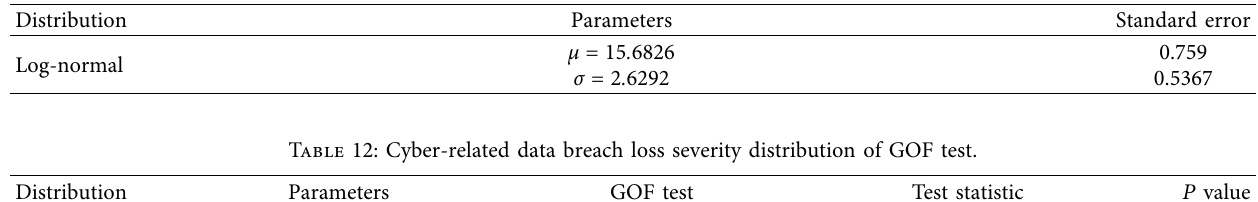
Figure 12: Cyber data breach loss severity histogram and its assumed distribution. Table 11: Cyber-related data breach loss severity distribution parameters.